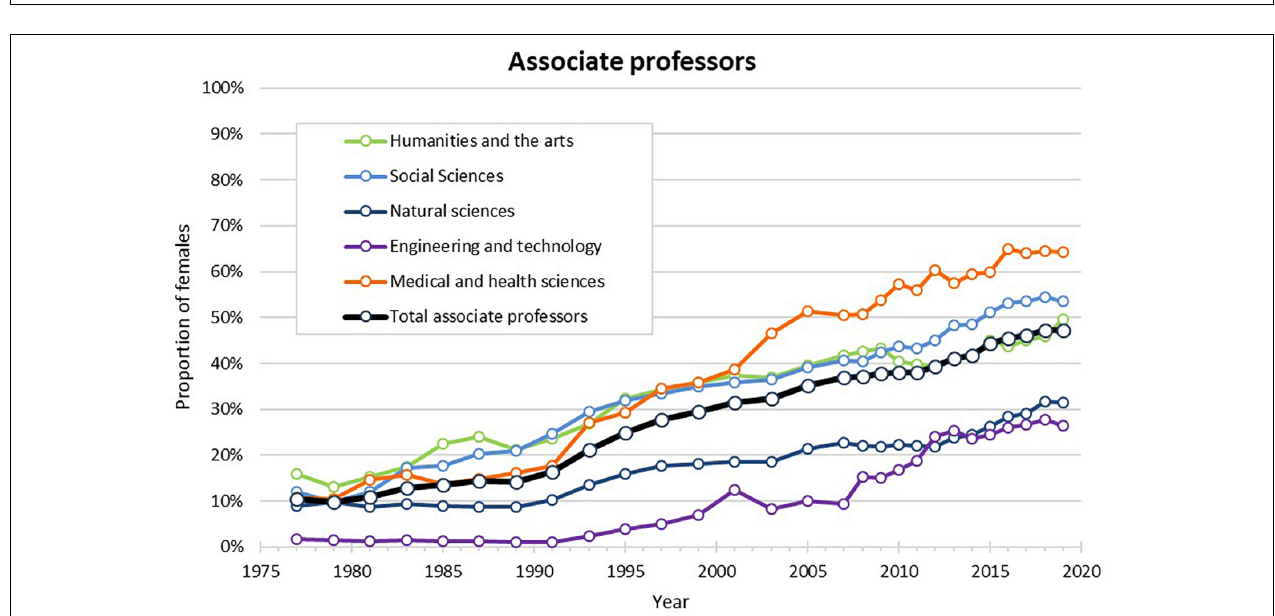
FIGURE 3 | Proportion of female associate professors at four Norwegian universities 1977 –